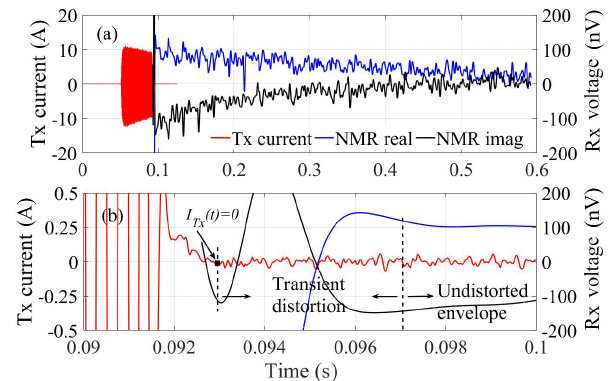
Figure 11. Excitation pulse (red) and the real (blue) and imaginary (black) parts of the surface-NMR signal envelopes. (a) Overview of excitation pulse and surface-NMR signal. (b) Zoom at the early- time